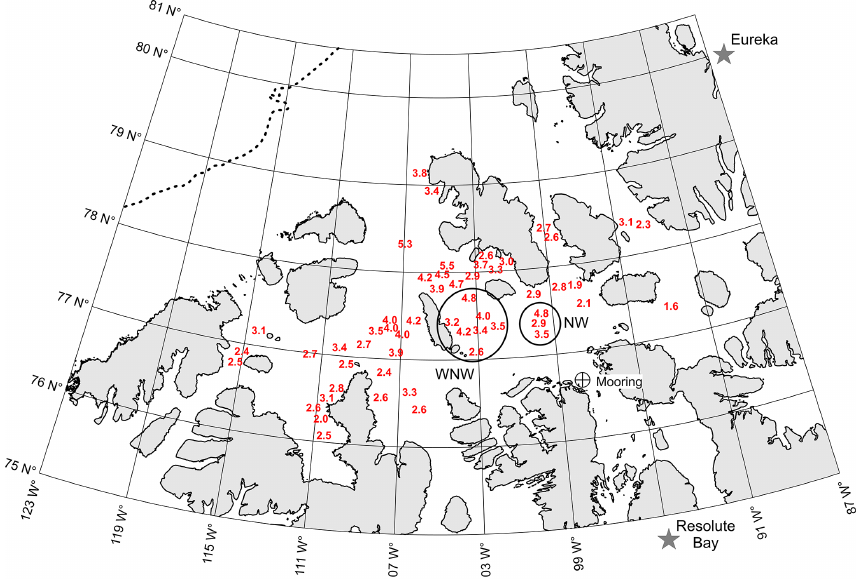
Figure 2. Mean thickness of sea ice in late winter, 1971–1980, derived from holes drilled during seismic surveys (Melling, 2002). Each value is the average from a median of 1835 boreholes, spaced at least 110yd (100.6m) apart on a 2D survey grid. Values used in reference to 2009 data are circled. Climate stations and the 2009–2010 mooring site are